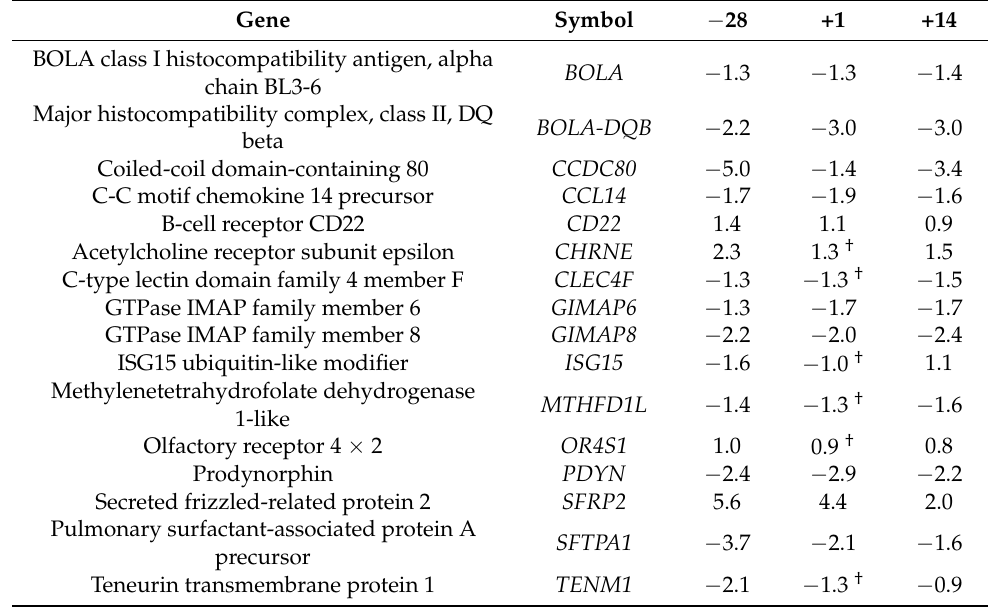
Table 2. Fold change 1 of genes with significant or marginal evidence of differential expression at all days relative to calving in liver samples from cows less or more susceptible to lipid-related metabolic disorders 2